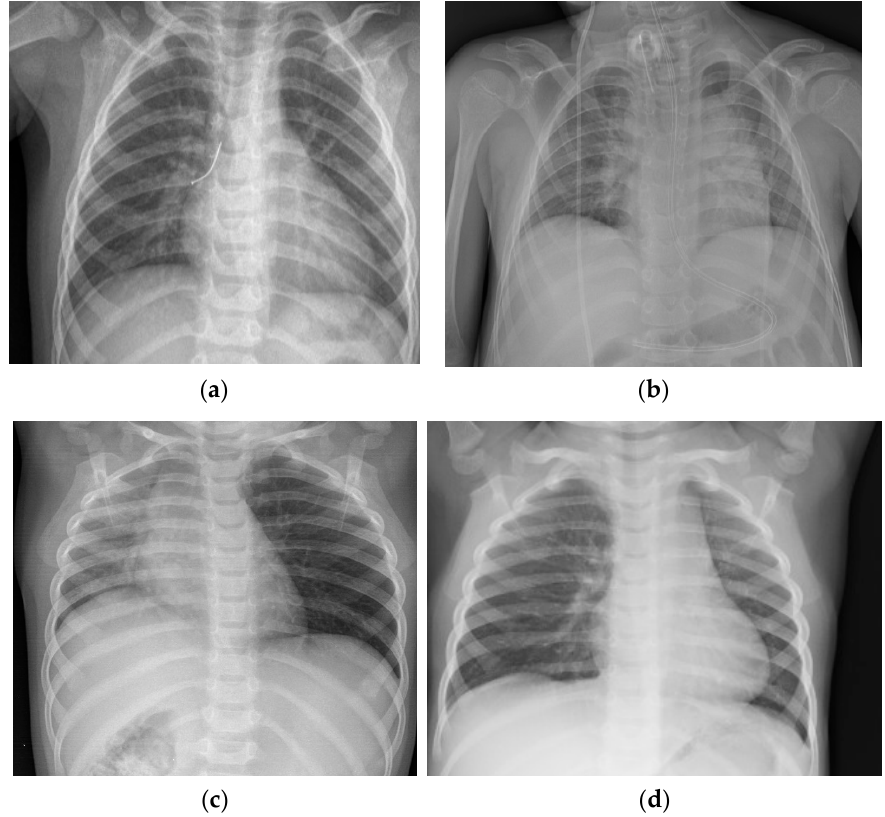
Figure 3. X-ray imaging results. ( a ) Evidence of foreign body in right bronchi; ( b ) intensified vascular pattern; ( c ) mediastinum dislocation to right side; ( d ) mediastinum dislocation to left side. In 24 cases (36.36%), no foreign body was identified during rigid bronchoscopy, while in the remaining 42 cases (63.64%), foreign body was present in airways. Foreign